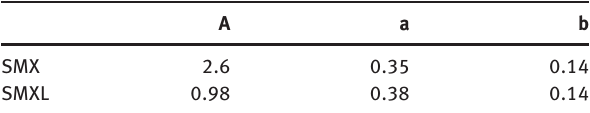
Table 1 Parameters for the heat transfer correlations